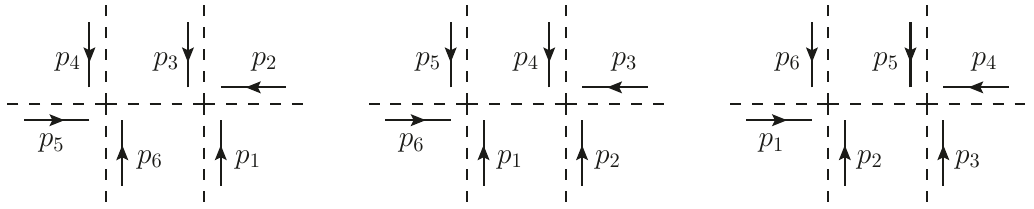
Figure 2. Contributions to M 6 from the 4-pt vertices: ( s 13 s 46 =P 2